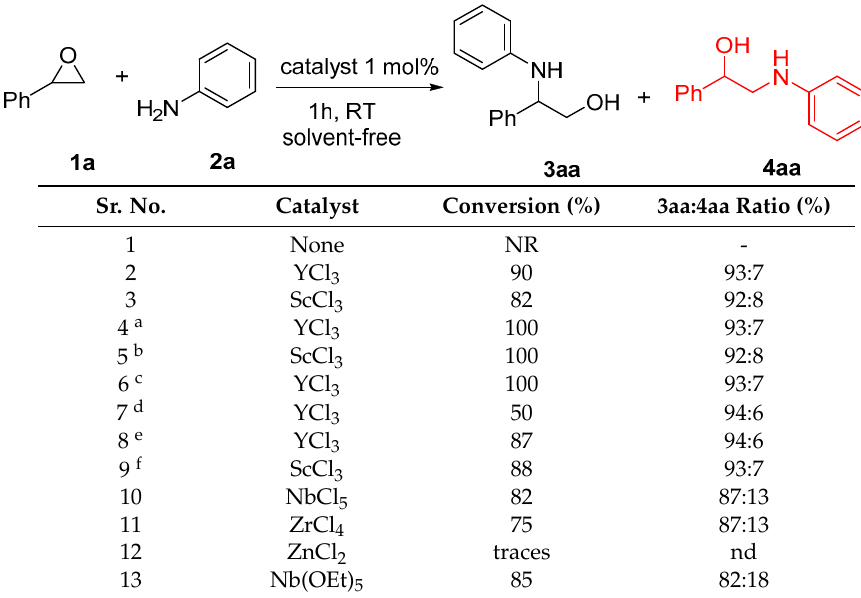
the presence of CHCl 3 (Table 1, entry 9) compared to solvent ‐ free conditions (100%) (Table 1, entry CHCl 3 (Table 1, entry 9) compared to solvent-free conditions (100%) (Table 1, entry 5). 5). Table 1. Optimization studies for the aminolysis of styrene oxide ( 1a ). Table 1. Optimization studies for the aminolysis of styrene oxide ( 1a